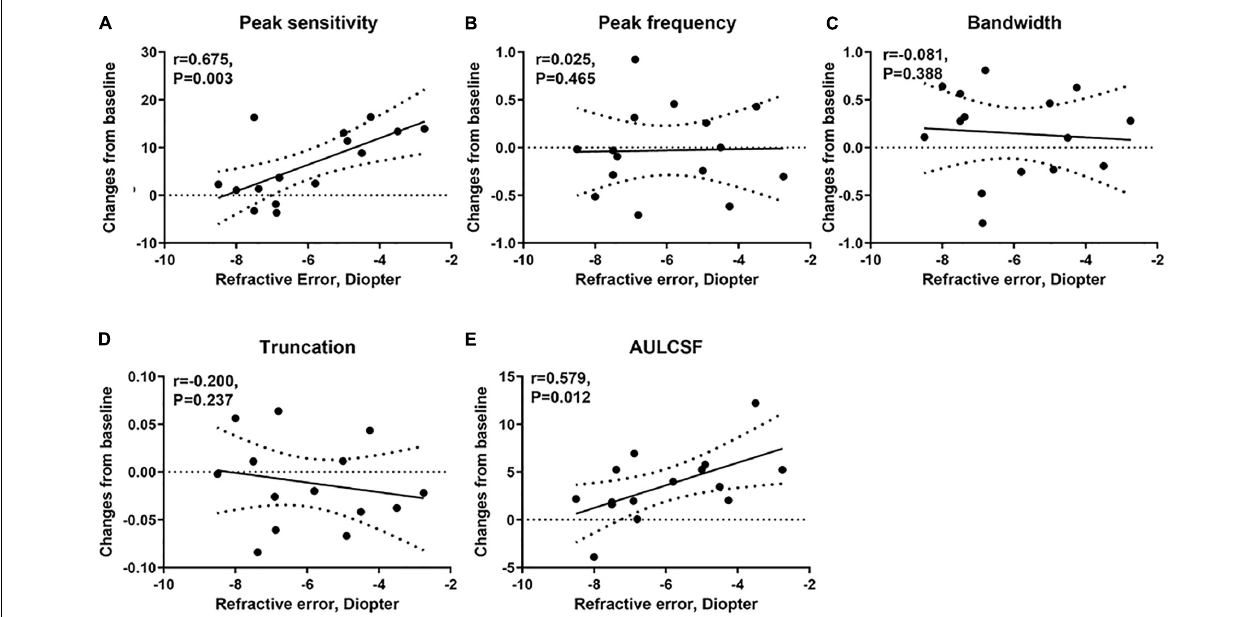
FIGURE 6 | The correlation of the changes in CSF parameters from baseline and refractive error in the experimental group. (A) The correlation of the changes in peak sensitivity from baseline and refractive error. (B) The correlation of the changes in peak frequency from baseline and refractive error. (C) The correlation of the changes in bandwidth from baseline and refractive error. (D) The correlation of the changes in truncation from baseline and refractive error. (E) The correlation of the changes in AULCSF from baseline and refractive error.